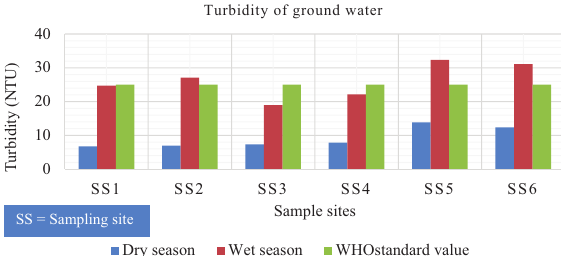
Figure 4 . Seasonal variation in turbidity of groundwater quality in the study area